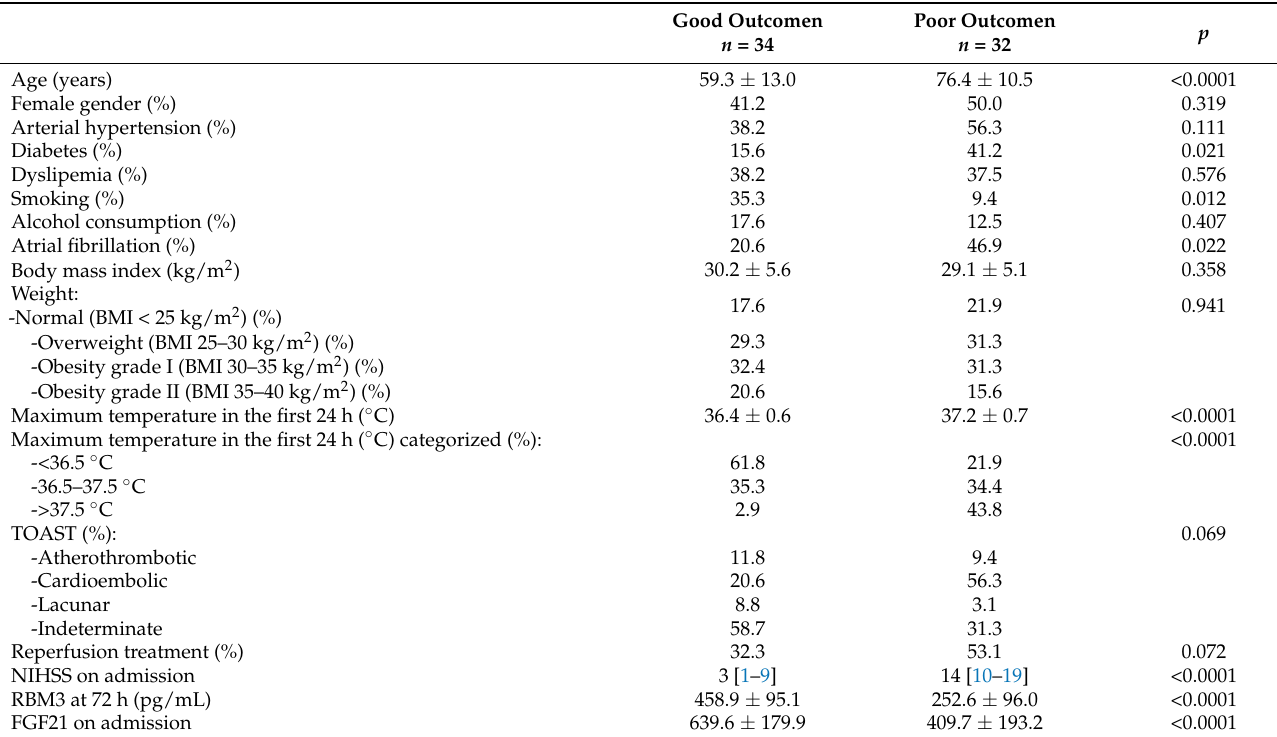
Table 3. Univariate analysis of the sample.